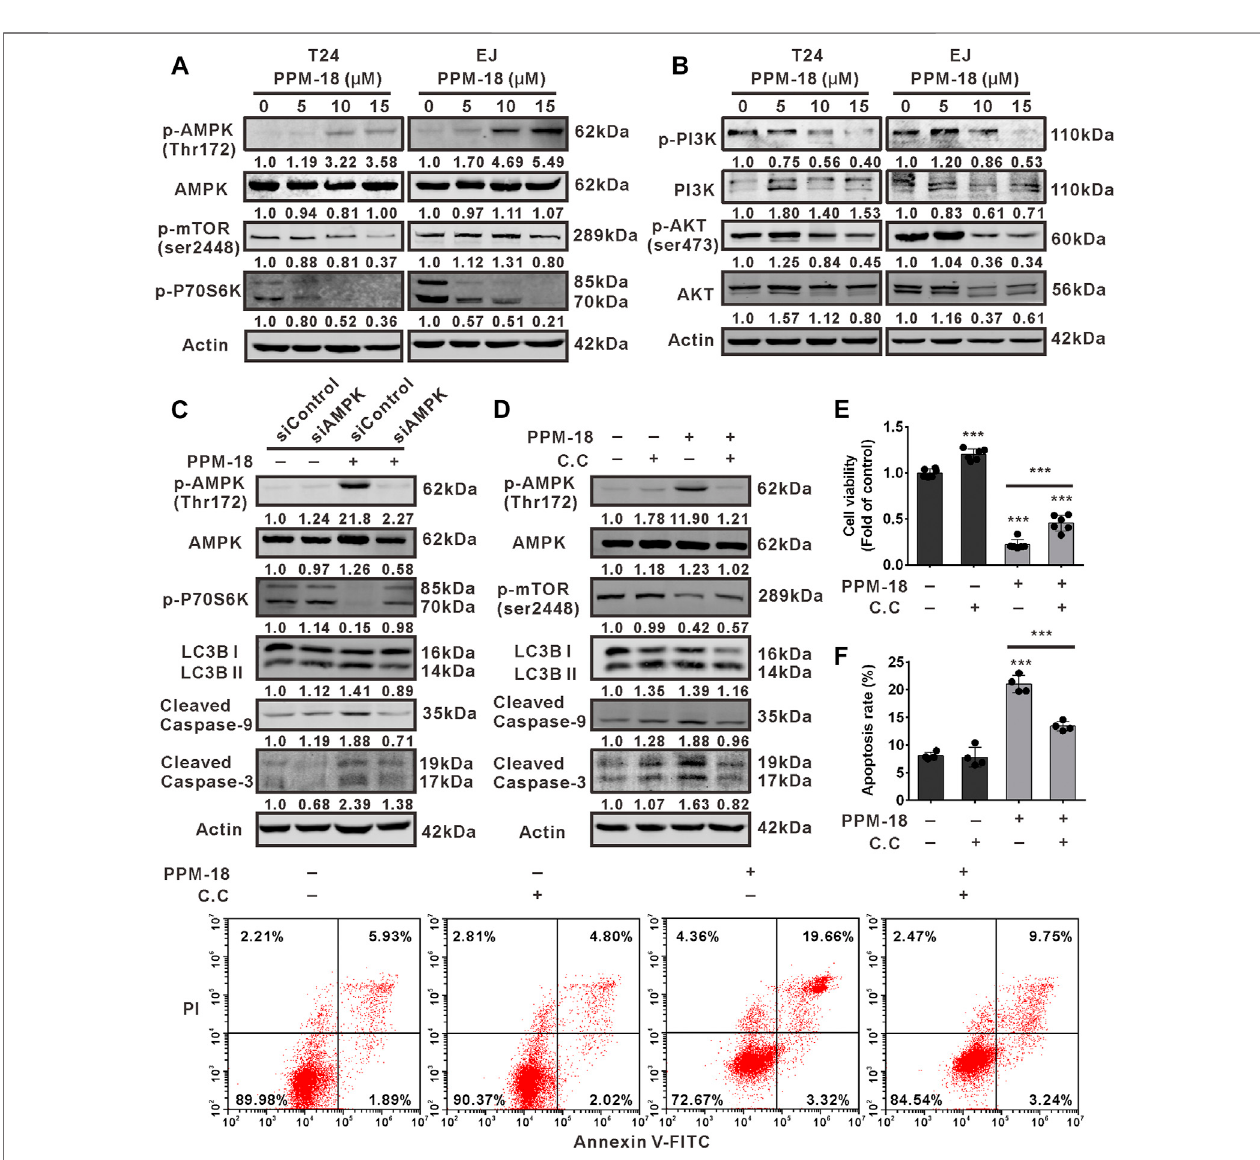
FIGURE 4 | PPM-18 induces AMPK-dependent autophagy and apoptotic cell death in bladder cancer cells. (A) and (B) T24 and EJ cells were exposed to the indicated concentration of PPM-18 for 24 h, and the expression of phospho-AMPK, AMPK, phospho-mTORC1, phospho-P70S6K, phospho-PI3K, PI3K, phospho- AKT, and AKT were analyzed by western blot. (C) and (D) Western blot showed the effect of AMPK siRNA or 5 μ M Compound C on the phosphorylation of AMPK, mTORC1, and P70S6K, and the expression of LC3B and cleaved caspase-9, 3 in PPM-18 – treated T24 cells. (E) and (F) MTS assay and fl ow cytometry demonstrated that treatment with CompoundC affected PPM-18 – reduced viability ofT24 cells and PPM-18 – induced apoptosis in T24 cells. Data are presented as the mean ± SD of at least three independent experiments. *** p < 0.001 vs. the control group, or vs. PPM-18+Compund C.